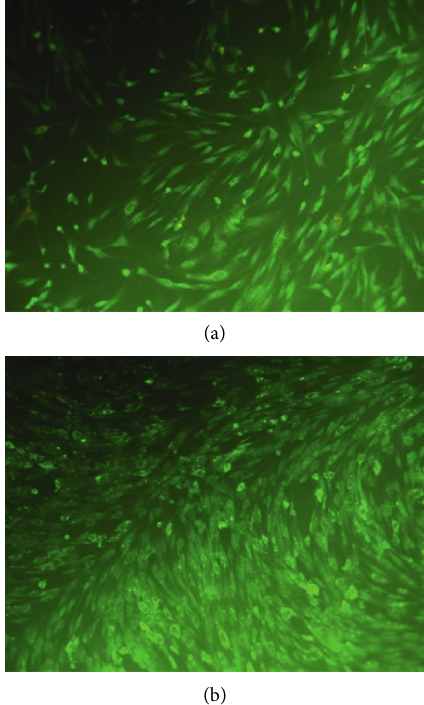
Figure 2: Morphology and cell density of the pulp cell culture after 72 hours stained with ethidium bromide-acridine orange: (a) untreated cells (control); (b) treated with 200 μ g/ml THA. The group treated with 200mg/ml THA demonstrated higher cell density (b) than the untreated group (a).